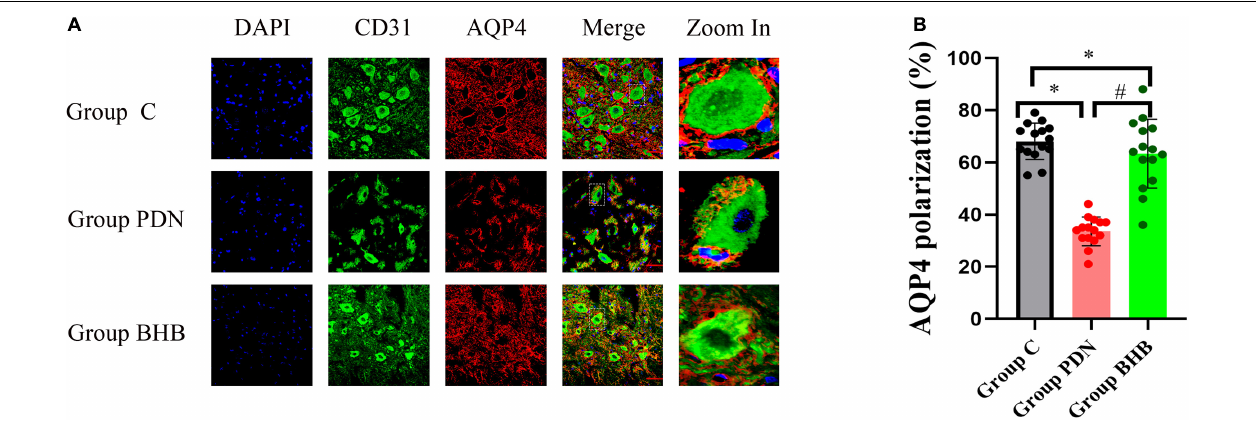
FIGURE 5 | Immunofluorescence results. (A) Immunofluorescence staining of sections, using anti-CD31 and anti-AQP4 antibodies, was obtained from the L5 segment of the spinal cord of rats in Group C, Group PDN, and Group BHB. Refer to Figure 1 for the meaning of the grouping abbreviation. AQP4-positive cells were identified with red fluorescence, CD31-positive cells were identified with green fluorescence, and the nuclei were counterstained with DAPI (blue). A typical part of AQP4 protein polarity reversal was zoomed in and shown in detail. Scale bar = 50 µ m. (B) Quantification of AQP4 polarization similarly demonstrated the polarity reversal of PDN rats and BHB can restore the reversed polarization. ∗ p < 0.05 compared with values in Group C. # p < 0.05 compared with values in Group